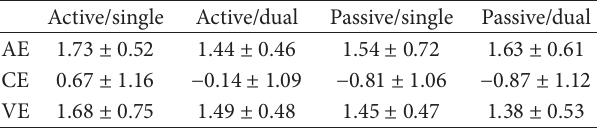
Table 1: Average joint position-matching errors in experiment 1a (mean ± standard deviation).